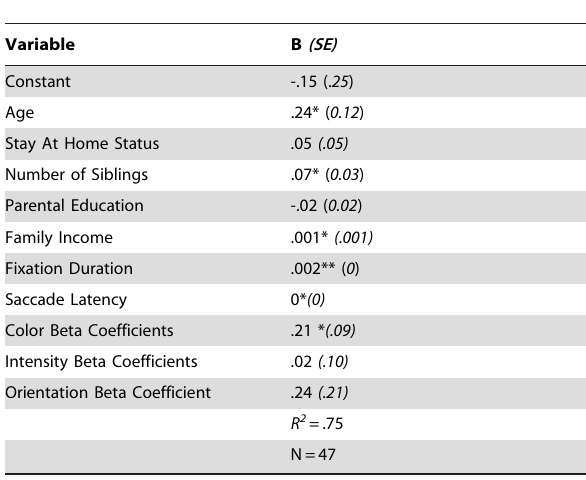
Table 1. Predictors of proportion attended